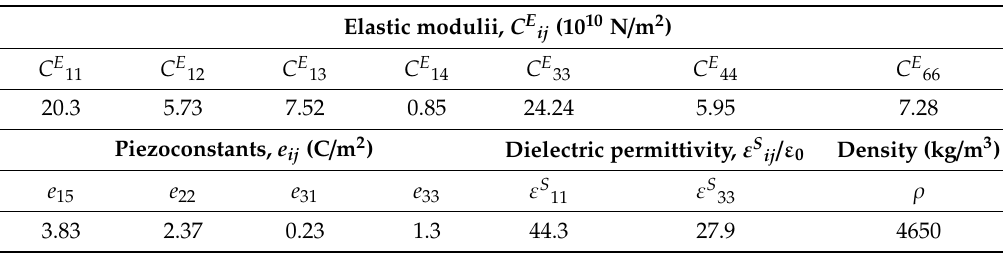
Table 2. Material constants of LiNbO 3 crystal [38].